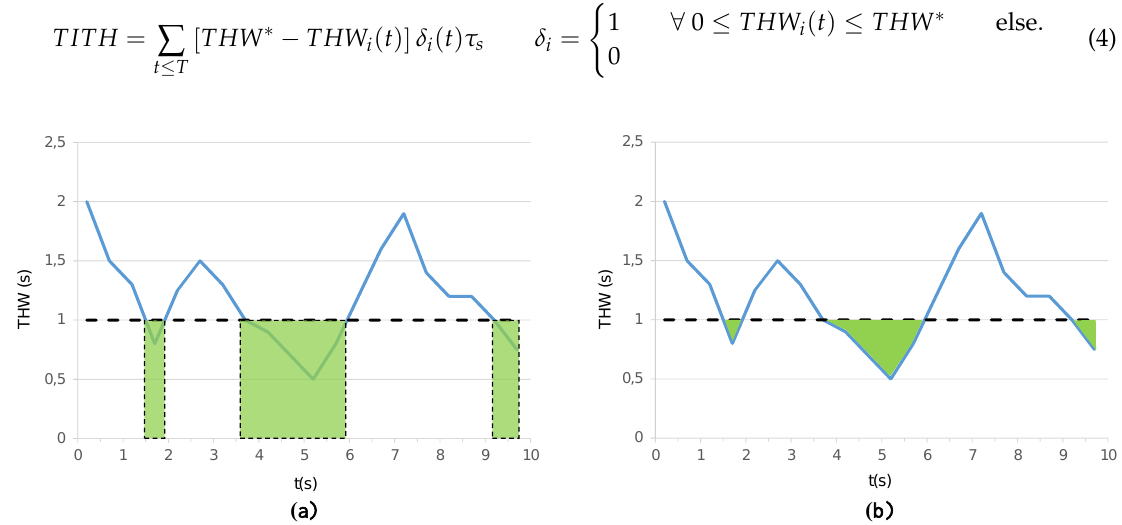
Figure 4. Representative example of car-following features: ( a ) time-exposed time headway (TETH) and ( b ) time-integrated time headway